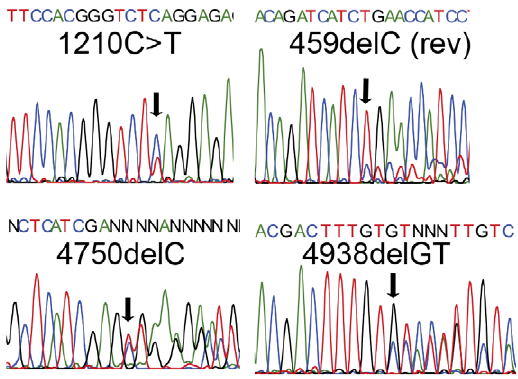
Figure 2. Representative sequencing traces demonstrating TSC2 mutations. A–D. Mutations in TSC2.